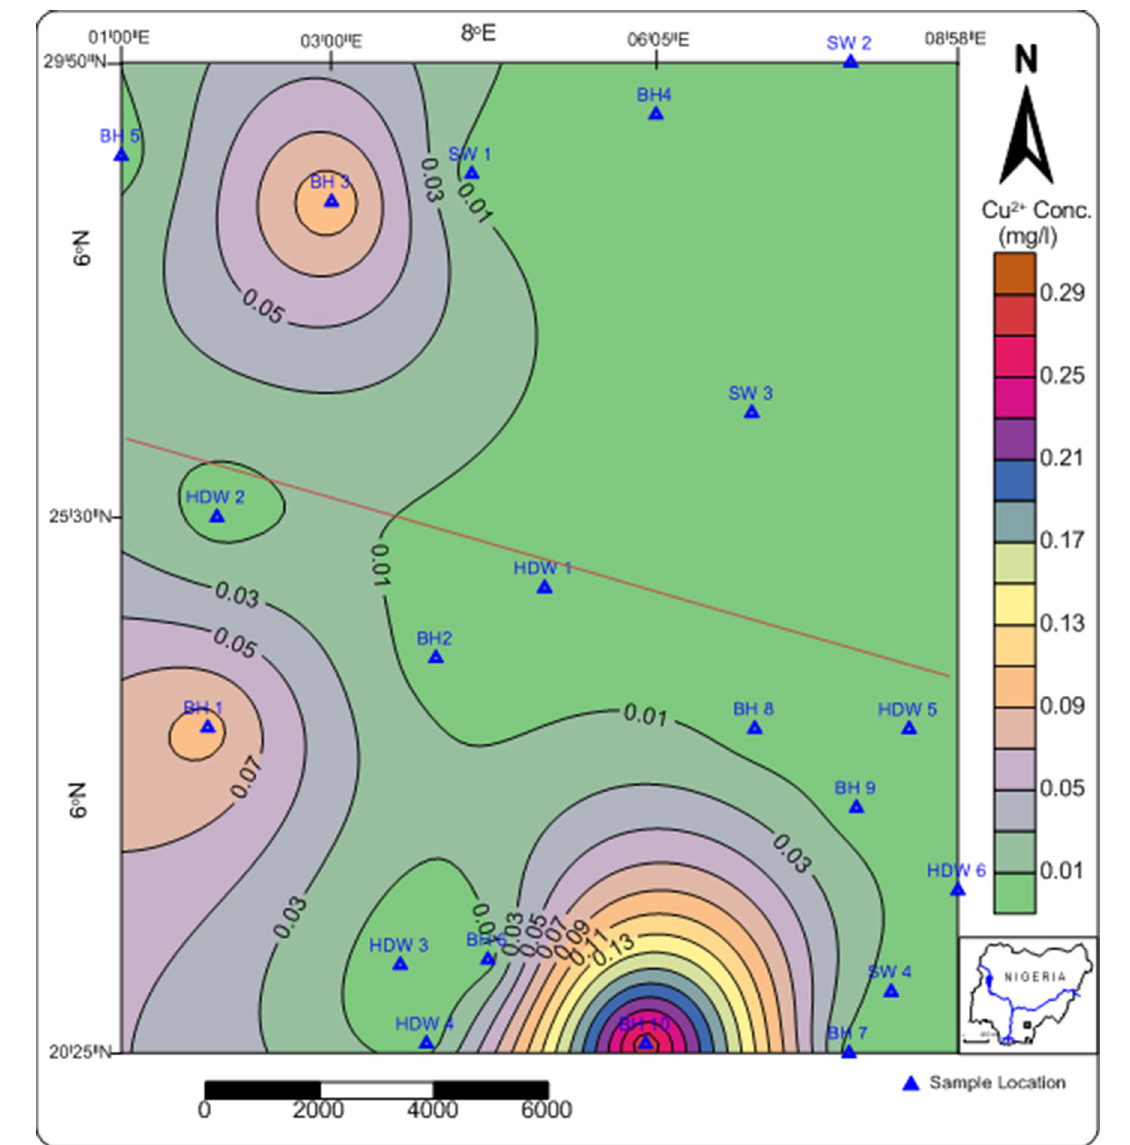
Fig. 20 Map for the dispersion of cobalt. Note : Perpendicular line indicates groundwater